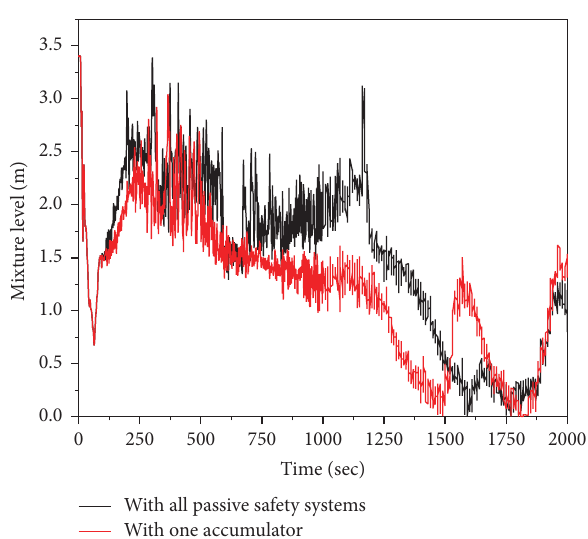
Figure 13: Mixture level above core active region without ADS stages 1–3